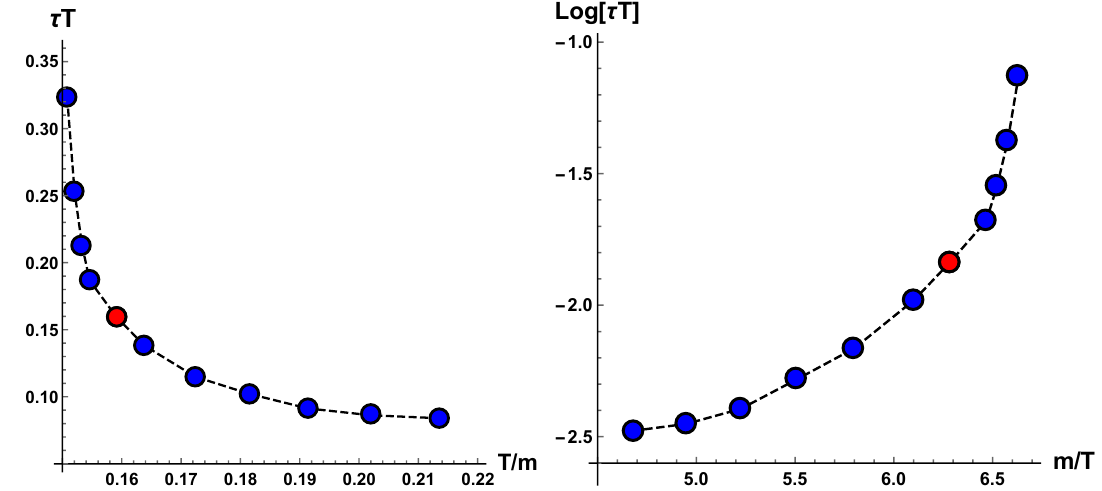
Figure 13 . The timescale (cid:28) governing the k-gap in function of temperature. The red dot is the analytic result at the \self-dual" temperature T ? . The dashed lines are just joining together the numerical data. It is important to notice the similarities of this behaviour with the well-known Vogel-Tammann-Fulcher law for